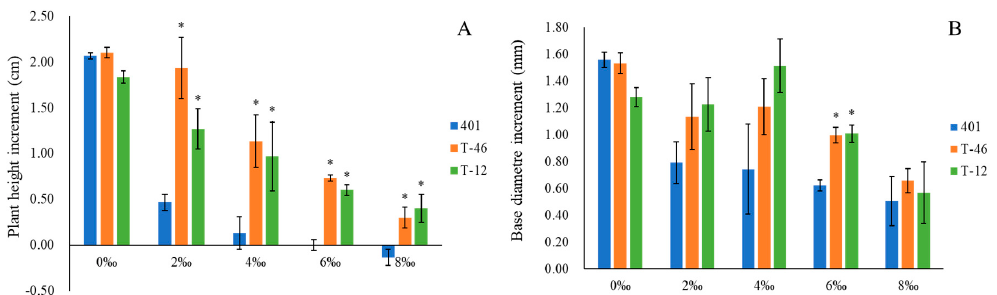
Figure 2. The stem height ( A ) and base diameter ( B ) increases of poplar after NaCl treatment. “*” denotes a significant difference ( p < 0.05, α = 0.05) between treatments. Error bars represent the standard deviation.